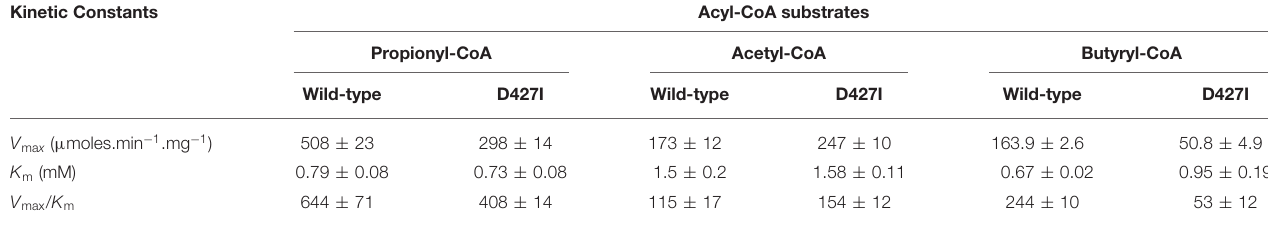
TABLE 2 | Michaelis-Menten kinetic constants for the carboxylation reaction catalyzed by TfAcCCase preparations that are constituted with either wild-type or TfAcCCB-D427I mutant subunit.